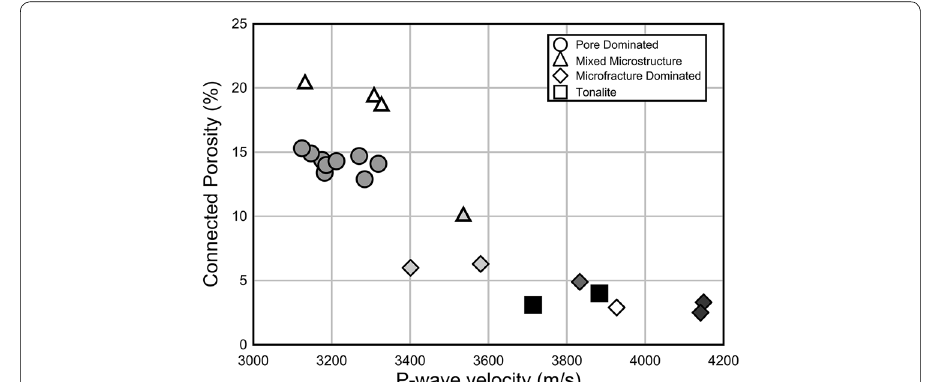
Fig. 9 Dry P-wave velocity versus connected porosity. Tone darkens with depth of sample, as shown in legend in Fig. 7a